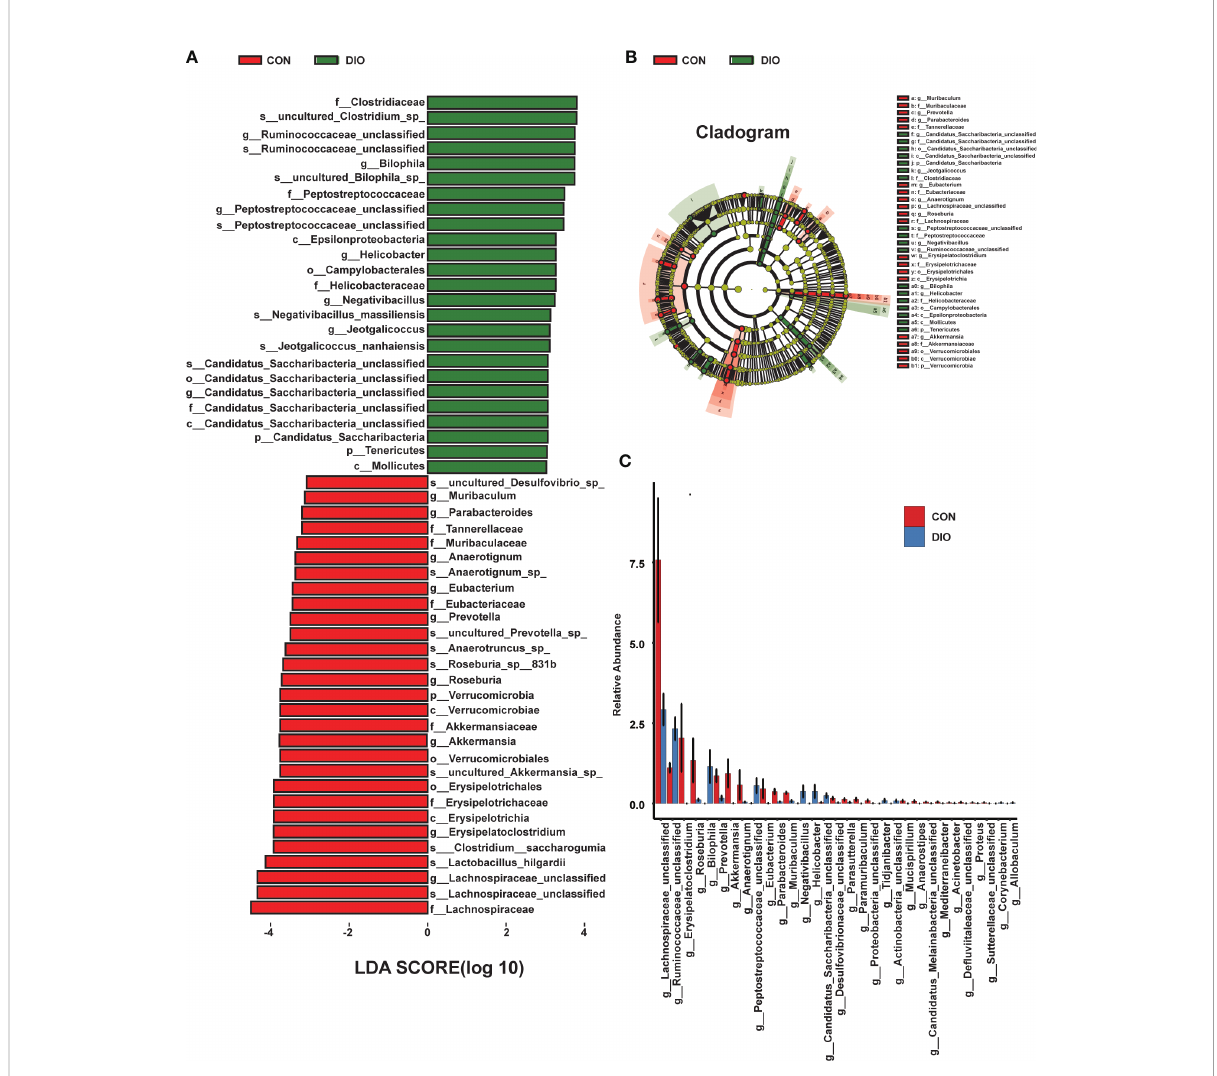
FIGURE 4 DIO changes the gut microbiota from the phylum to species levels. (A) LEfSe analysis of gut microbiota in the CON and DIO groups, n = 6, LDA score > 4.0. Red represents increased microbiota in the CON group; green represents increased microbiota in the DIO group. (B) The relationships among different microbiota from the phylum to species levels are shown in the cladogram, n = 6. (C) Signi fi cant difference analysis at genus level, n = 6, Wilcox test P-value <